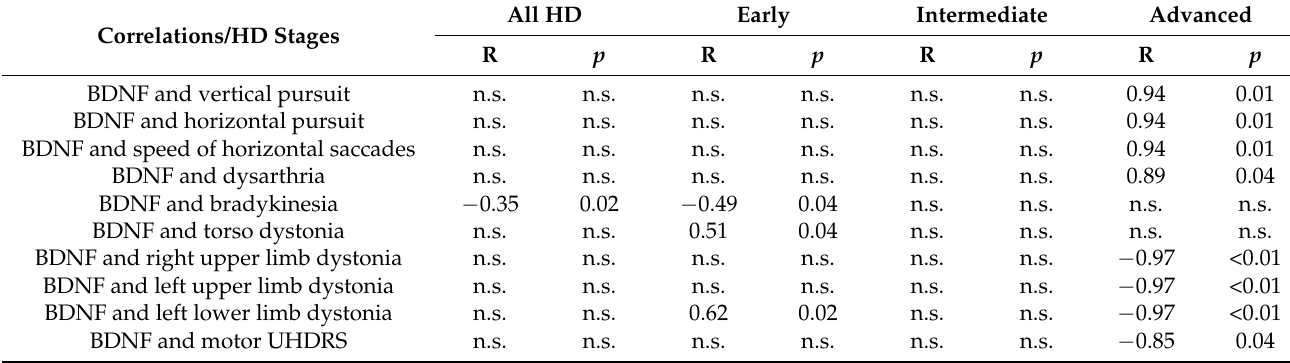
BDNF and left upper limb dystonia